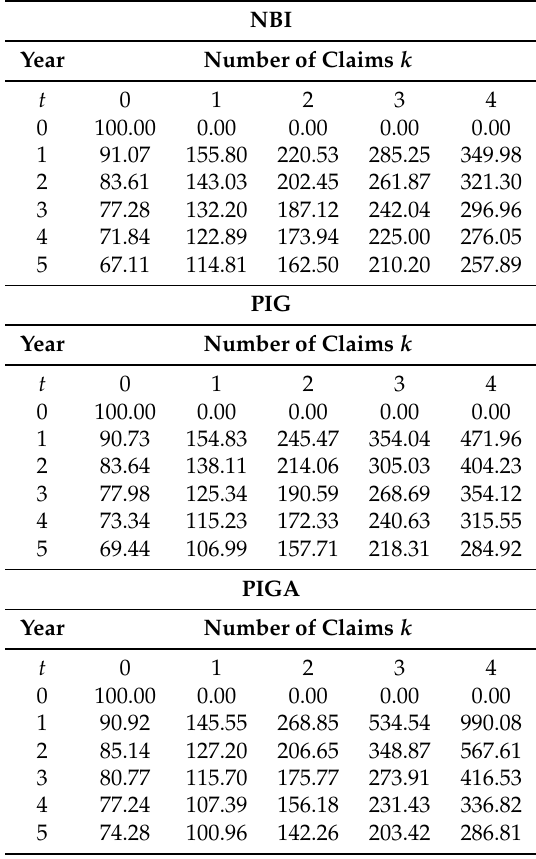
Table 6. A Posteriori, or Bonus-Malus, premiums, distributions.